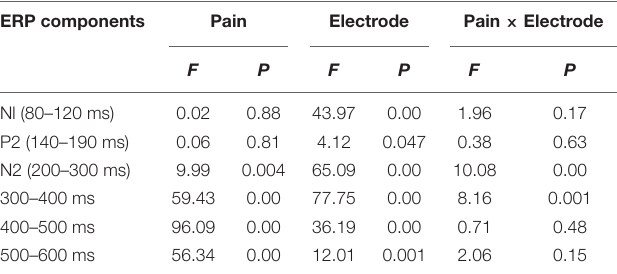
TABLE 1 | Summary of results of ANOVAs for the Nl, P2, N2, 300–400, 400–500, and 500–600 ms time